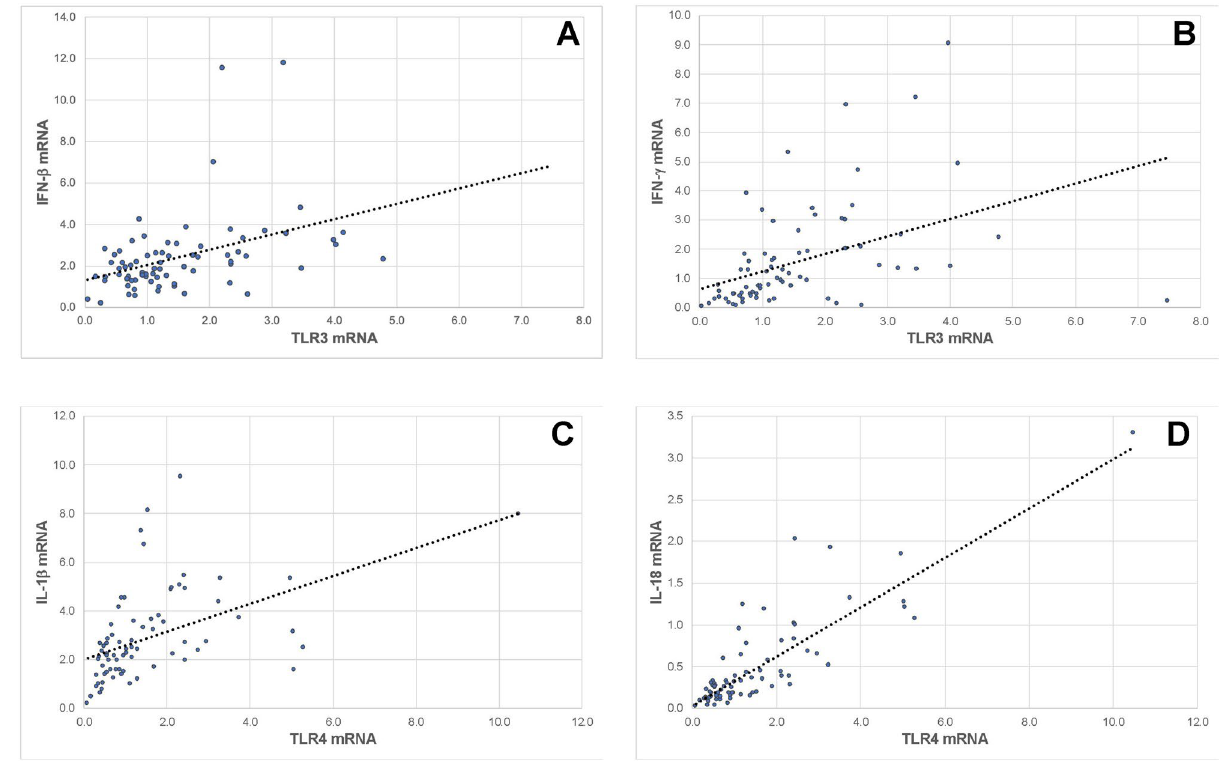
Figure 3. Association between Toll-like Receptors (TLRs) 3 and 4 and cytokine expression. The expression of IFN-γ and IFN-β was positively associated with TLR3 expression (Panels A and B ) with R 2 = 0.263 and 0.282, respectively. Expression of pro-IL-1β and IL-18 was positively associated with the expression of TLR4 (Panels C and D), with R 2 = 0.239 and 0.713, respectively. Pearson correlation coefficient was used in R software (version 4.0.3 for